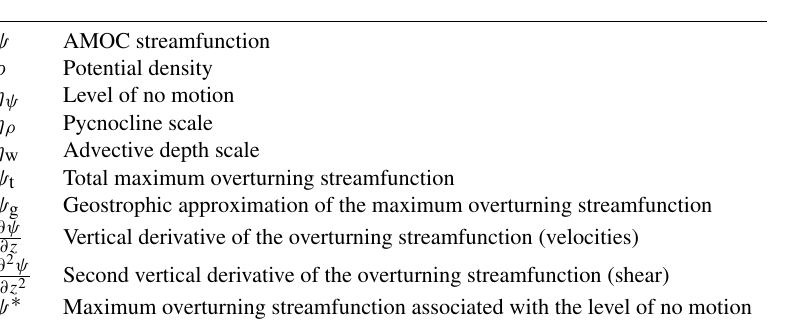
Table 2. Experimental